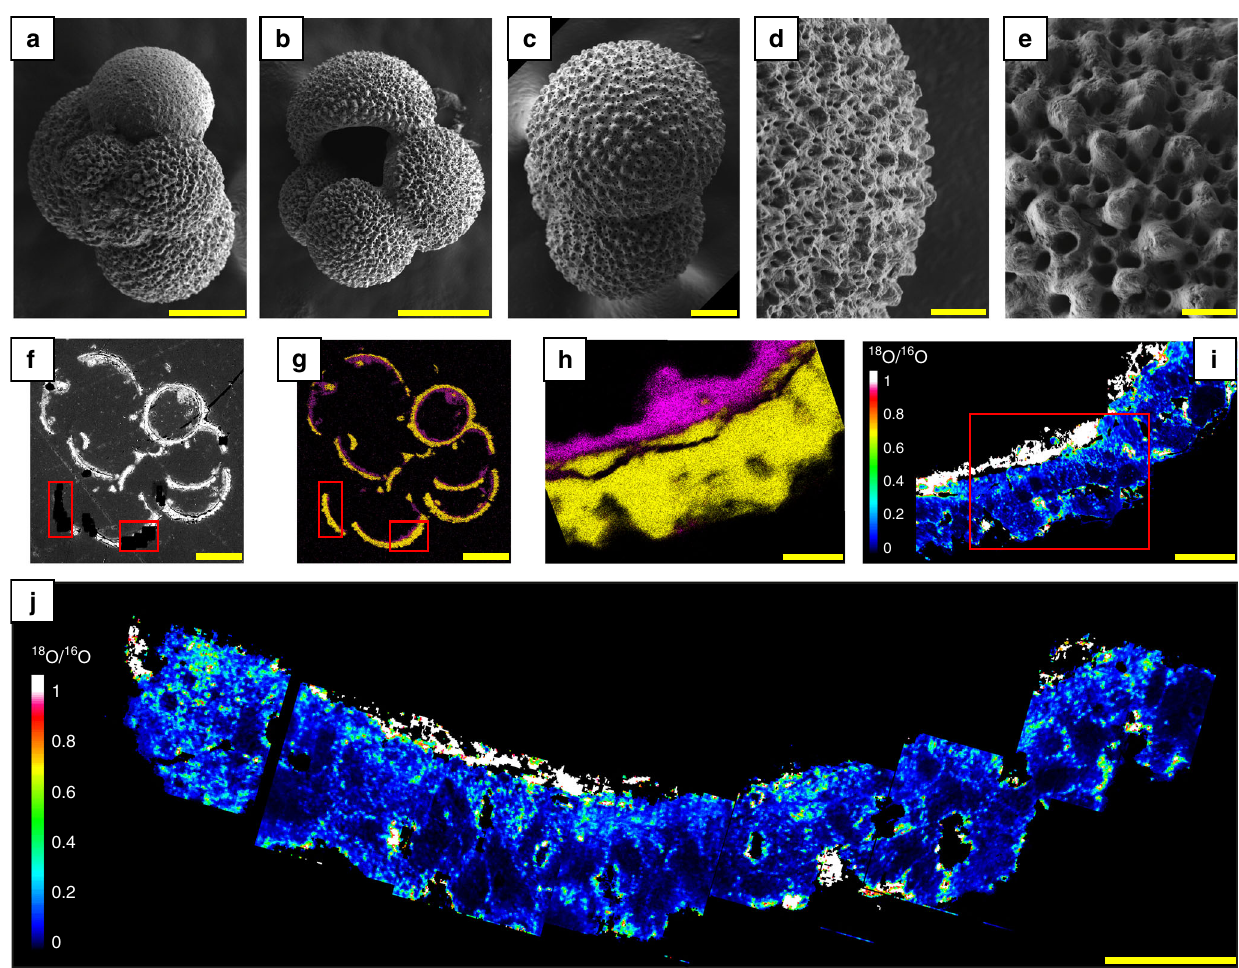
Fig. 2 Foraminifera tests after isotope re-equilibration experiments. a – e SEM images showing the overall morphologies and ultrastructures of the foraminifera tests ( G. bulloides ) after their ultrasonic cleaning in pure ethanol. f Backscattered SEM image of a polished section of a test embedded in epoxy. g , h EDXS maps showing the spatial distributions of carbonates (Ca appears in yellow) and clays (Si appears in pink). i , j NanoSIMS maps showing the 18 O/ 16 O ratio distributions in carbonates and clays. Carbonates exhibit a 18 O/ 16 O ratio ranging from 0.1 to 0.8, while clays exhibit a 18 O/ 16 O ratio ranging from 0.9 to greater than 1.0. Note that the isotope exchange occurred very heterogeneously, leading to areas that are more or less enriched in 18 O. The red rectangles in f , g indicate the locations of i , j . The red rectangle in i indicates the location of h . Scale bars are 100 µ m ( a , b , f , g ), 50 µ m ( c ), 20 µ m ( d , i ) and 10 µ m ( e , h , j